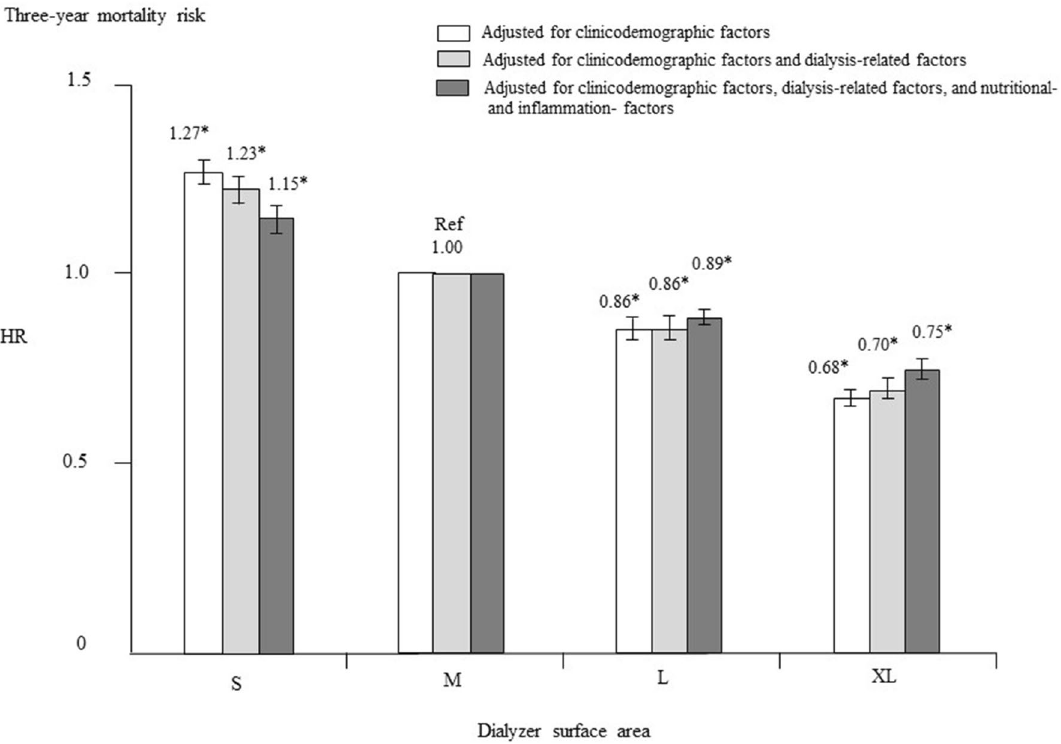
Figure 3. Hazard ratios (HRs) for all-cause mortality in 234,638 patients undergoing hemodialysis according to dialyzer surface area, determined using standard Cox proportional hazards regression analysis. White bars are adjusted for basic factors, including age, sex, dialysis vintage, presence/absence of diabetes mellitus, and presence/absence of cardiovascular complications. Gray bars are adjusted for dialysis-related factors, as assessed by the Kt/V value, β 2 -microglobulin level, ultrafiltration rate, dialysis time, and type of dialyzer in addition to basic factors. Dark gray bars are adjusted for basic factors, dialysis-related factors, and nutrition-related and inflammation-related factors, including body mass index, C-reactive protein, hemoglobin, calcium, phosphate, intact parathyroid hormone, and serum albumin levels, normalized protein catabolic rate, and simplified creatinine index. * P < 0.0001, versus M (reference) group. Error bars correspond to the 95% confidence intervals. S group, small dialyzer surface area, < 1.5 m 2 ; M group, medium dialyzer surface area, 1.5 m 2 ; L group, large dialyzer surface area, 1.6 to < 2.0 m 2 ; XL group, extra-large dialyzer surface area, ≥ 2.0 m 2